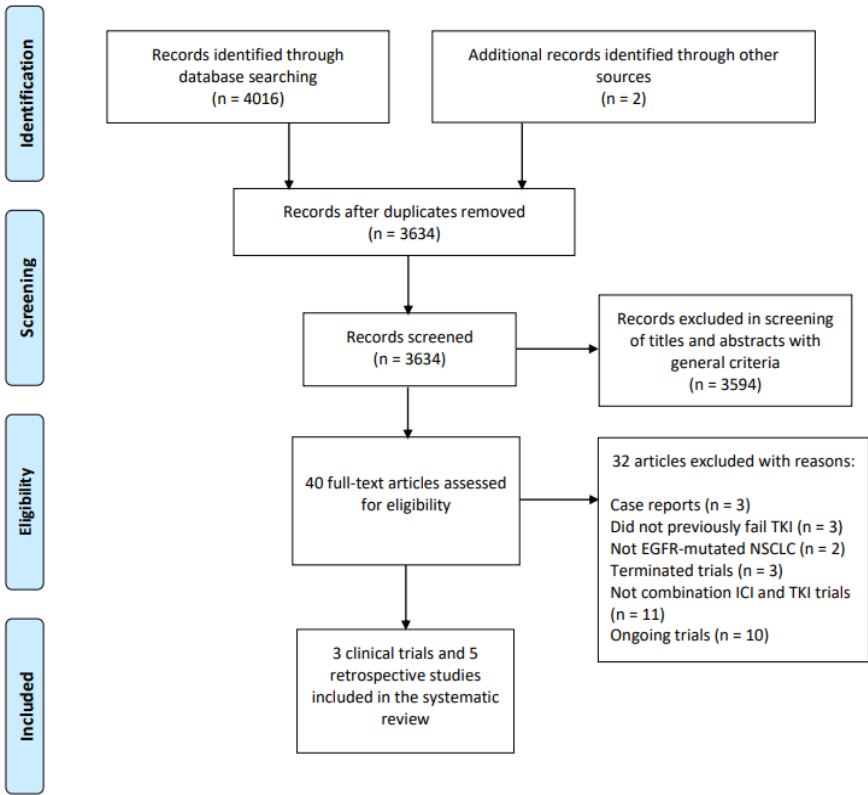
Figure 1 . PRISMA flow chart showing the identification and selection of included studies . Figure 1. PRISMA flow chart showing the identification and selection of included